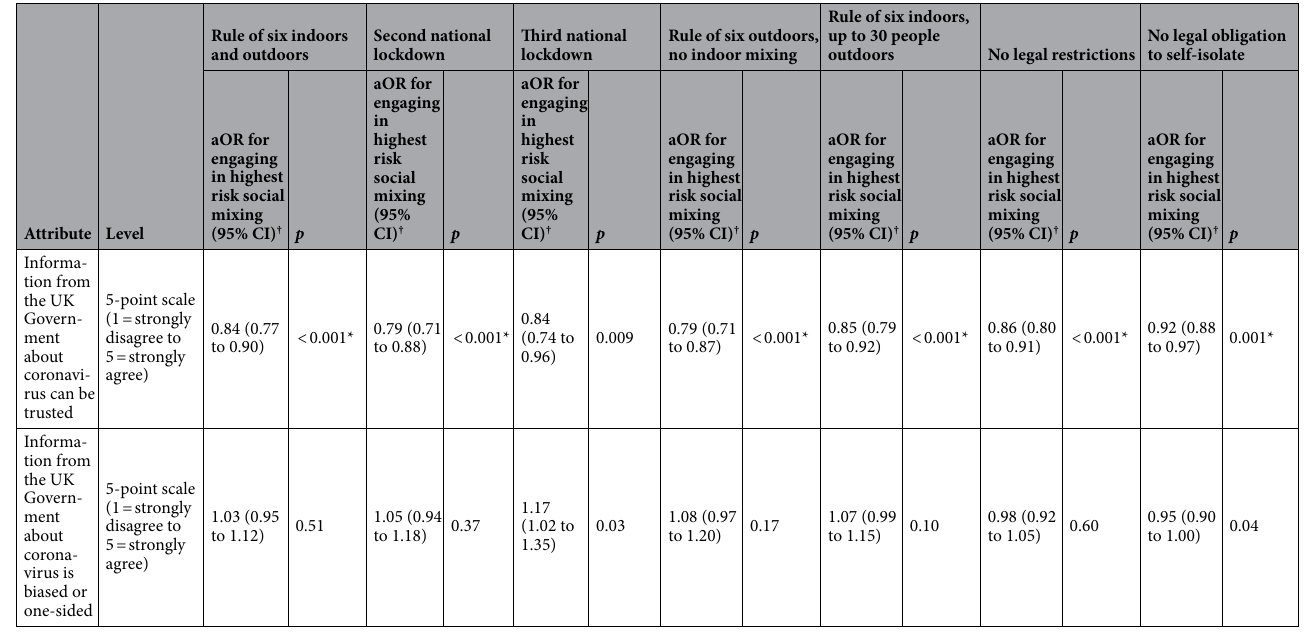
Table 6. Contextual and psychological factors associated with engaging in highest risk social mixing at different time points in the pandemic. † Adjusting for wave, region, gender, age (raw and quadratic), presence of a dependent child in the household, having a chronic illness oneself, having a household member who has chronic illness, employment status, highest earner in household works in a manual occupation, index of multiple deprivation, highest educational or professional qualification, ethnicity, first language, living alone, relationship status, having had COVID-19 before, and financial hardship. * p ≤